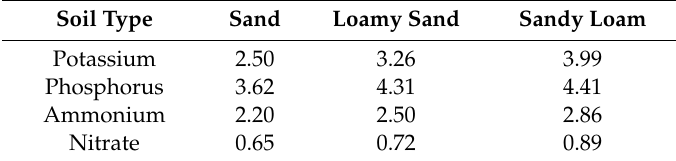
Table 4. Distribution coe ffi cient for fertilizers in the di ff erent soil types (cm 3 g − 1